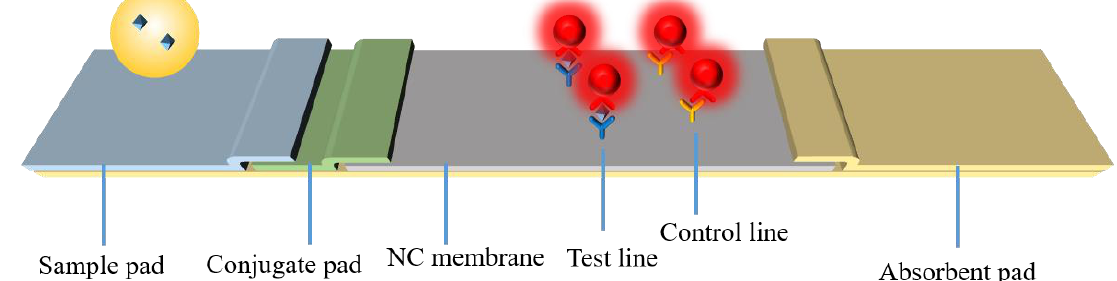
Figure 1. Schematic diagram of immunochromatographic diagnostic strip. Poly(vinylidene fluoride) (PVDF) is a semi-crystalline polymer with -(CH 2 -CF 2 ) n - re-